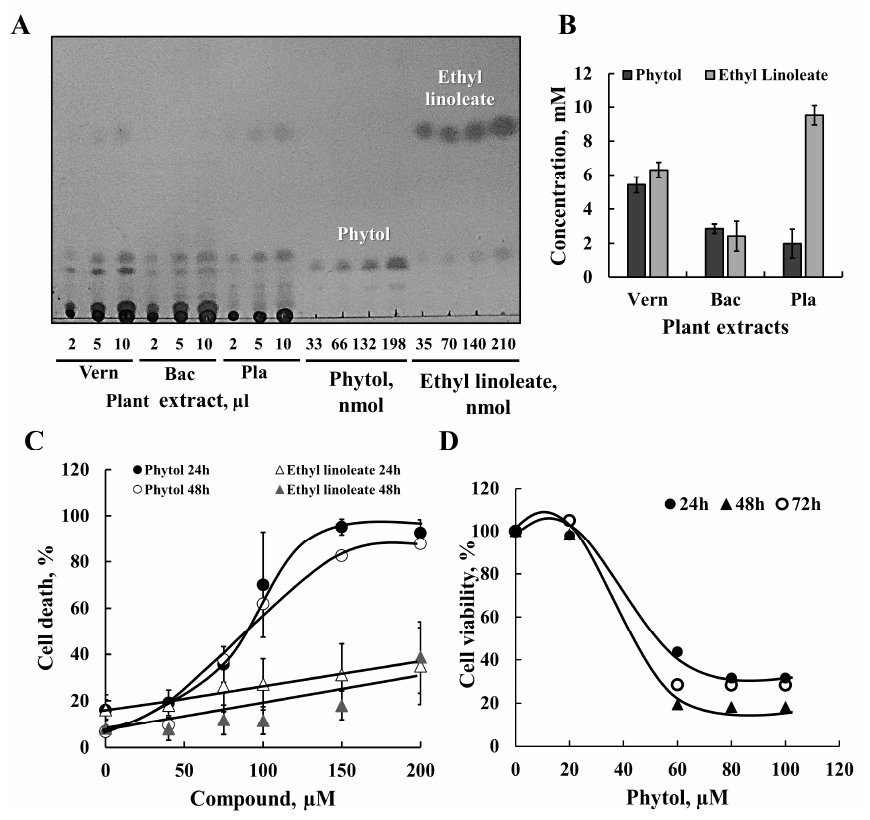
Figure 4. GC-MS analysis of the plant extracts and phytol as one of the cell death active compounds . ( A ) Ethanolic extracts from Vern, Bac, and Pla plant extracts were subjected to TLC separation, along with known amounts of phytol and ethyl linoleate using the solvent mixture of petroleum ether:diethyl ether:acetic acid (85:15:1, V:V:V) and developed by exposure to iodine vapor. ( B ) Quantification of phytol and ethyl linoleate in plant extracts using the compounds’ calibration curves and Image J software ( n = 3). ( C ) SH-SY5Y cells were incubated for 24 h or 48 h ( C ) with the indicated concentration of phytol or ethyl linoleate, and cell death was evaluated using PI staining and FACS analysis. Results are the mean ± SEM ( n = 3). ( D ) Cell survival was assayed following 24, 48, or 72 h incubation with the indicated concentrations of phytol, using an XTT assay. Next, the activity of the phytol and ethyl linoleate in inducing cell death was ana- lyzed by incubating SH-SY5Y cells with different concentrations (50–200 μ M) for 24 or 48 h (Figure 4C). Phytol induced cell death with half-maximal cell death (IC 50 ) of about 80% at 70 μ M. Ethyl linoleate showed weak cell death activity, increasing from 15% in non- treated cells to about 40% at 200 µ M of ethyl linoleate (Figure 4C). Phytol also highly reduced